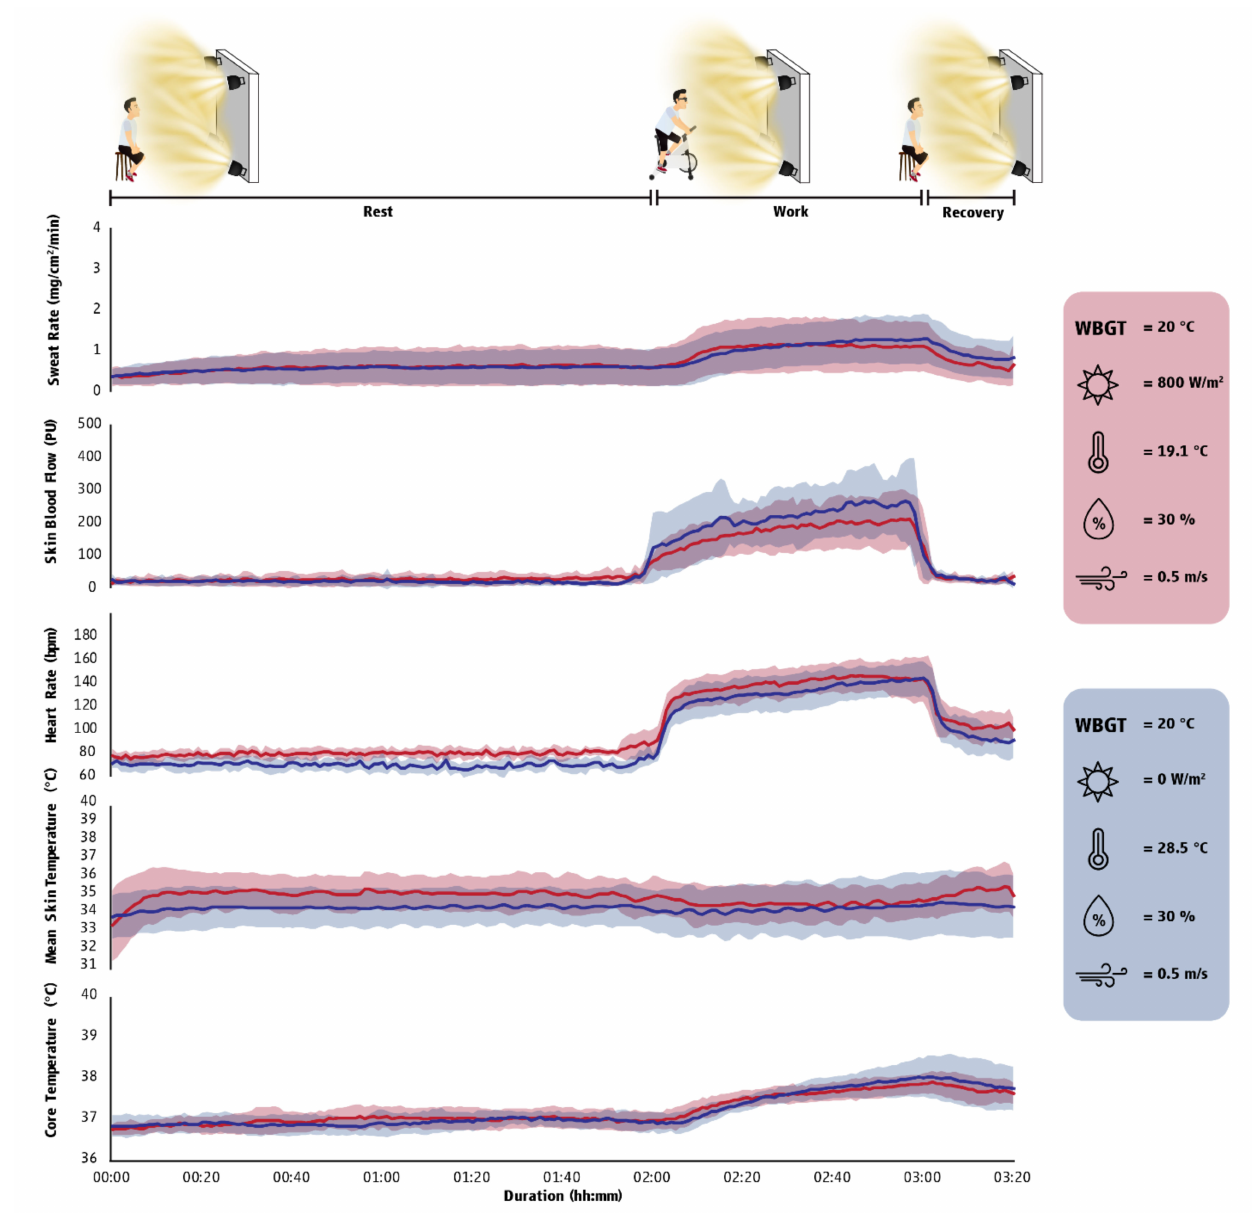
Figure 4. Physiological responses (mean ± SD) during exposure in a temperate environment (20 ◦ C WBGT). The first two hours (00:00 to 02:00) illustrate the fluctuation of physiological responses in resting conditions, the third hour (02:00–03:00) illustrate physiological responses during exercise/work, while the final 20 min (03:00–03:20) show the responses during recovery time. Red indicates a thermoneutral outdoor environment, while blue indicates a thermoneutral indoor environ- ment. Sweat rate corresponds to the average sweat rate from the forehead, arm (bicep), and thigh (quadricep) as measured using the ventilated capsule technique, expressed in milligrams per centimeter square per minute. Skin blood flow as measured by laser-Doppler flowmetry corresponds to the average skin blood flow from the forearm (brachioradialis) and leg (gastrocnemius), expressed in perfusion units. Heart rate is expressed in beats per minute. Mean skin temperature estimated from the arm, chest, thigh, and leg skin temperatures, expressed in degrees Celsius. Core temperature corresponds to gastrointestinal temperature, expressed in degrees Celsius. Effect sizes for all comparisons between outdoor and indoor environments can be found in Table